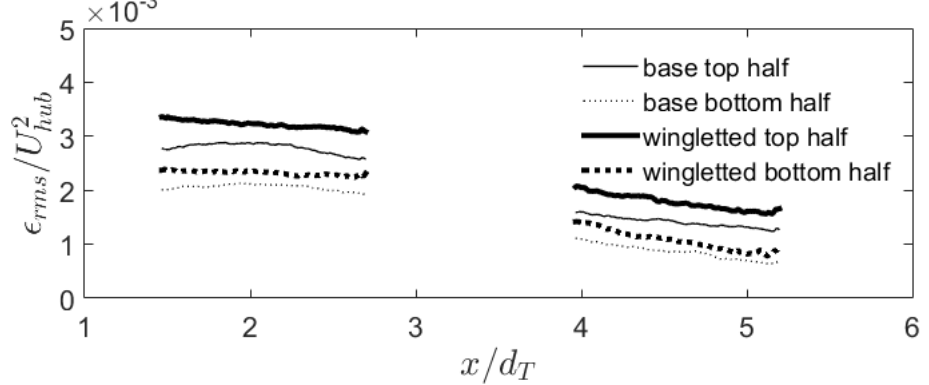
Figure 11. Normalized root mean square error ( (cid:15) downstream